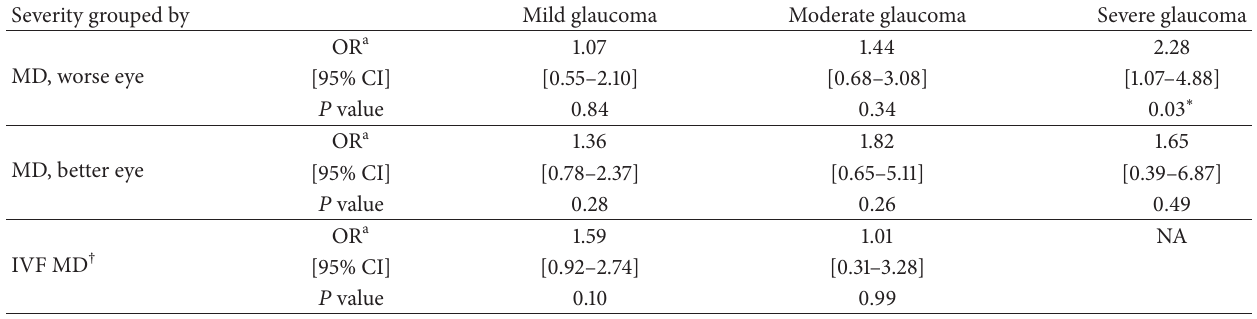
Table 5: Glaucoma severity and MVC prevalence.